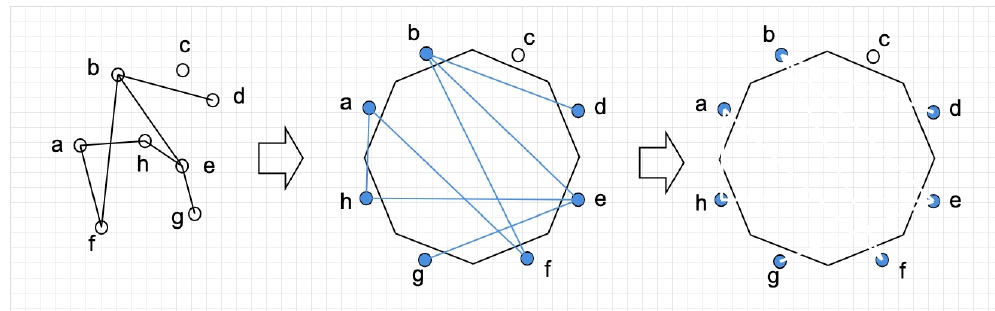
Figure 6. Visibility graph representation on a simplified terrain. Left: a graph. Mid: the vertices are located on a polygon of n edges; the black polygon represents a “wall”. Each edge e ( u , v ) in the graph is marked as a (blue) segment in the polygon. Right: each visibility segment is marked in white to allow a “visibility window” related to each edge in the